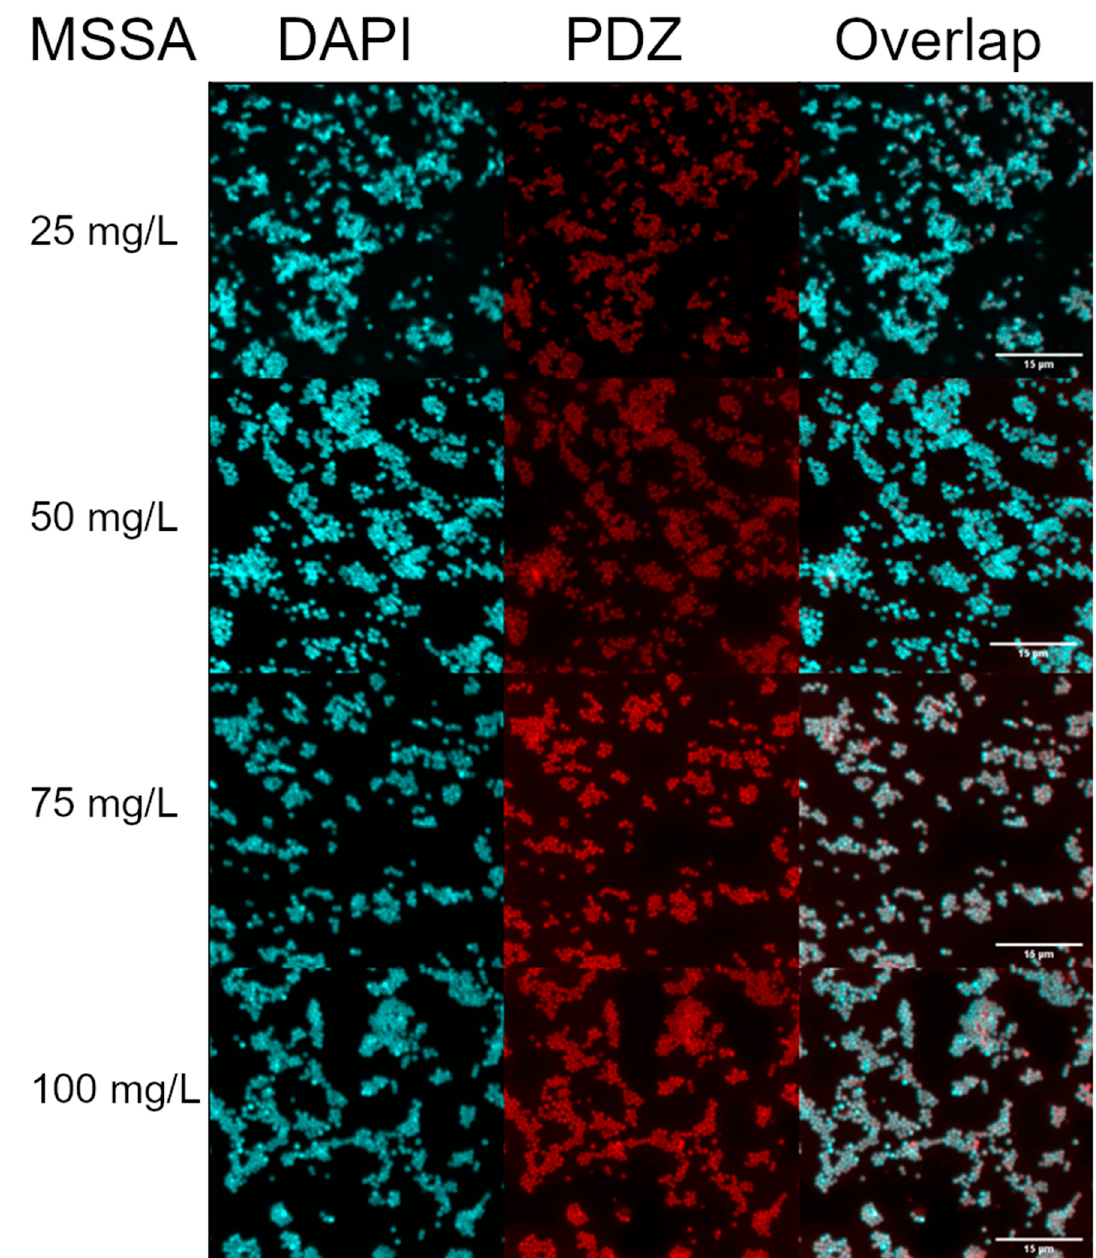
Figure 1. Internalization of PDZ in MSSA strains at 100, 75, 50, and 25 mg/L after 15 min of incubation, observed under Confocal Microscopy. The marking of the bacterial DNA with DAPI is observed in blue, and the PDZ interaction with bacterial strains, in red, as well as the overlapping of signals.